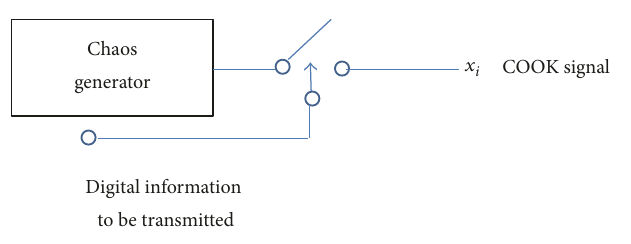
Figure 3: CDSK transmitter.